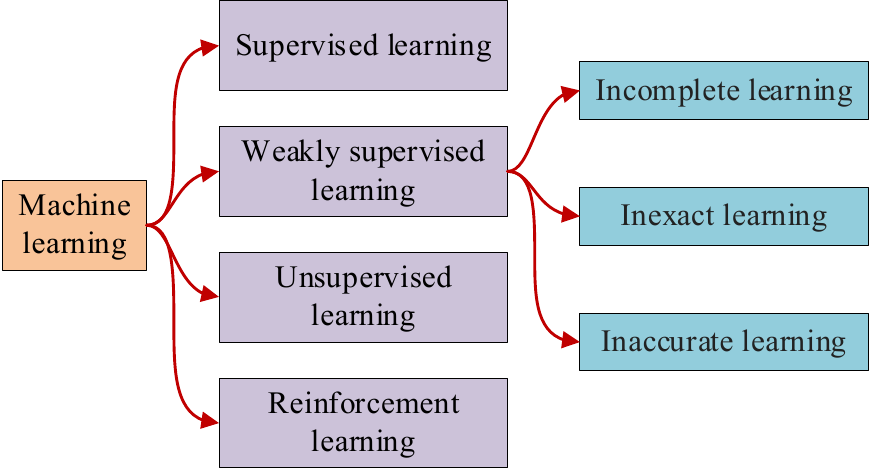
Figure 3. Sub-categories of machine learning .